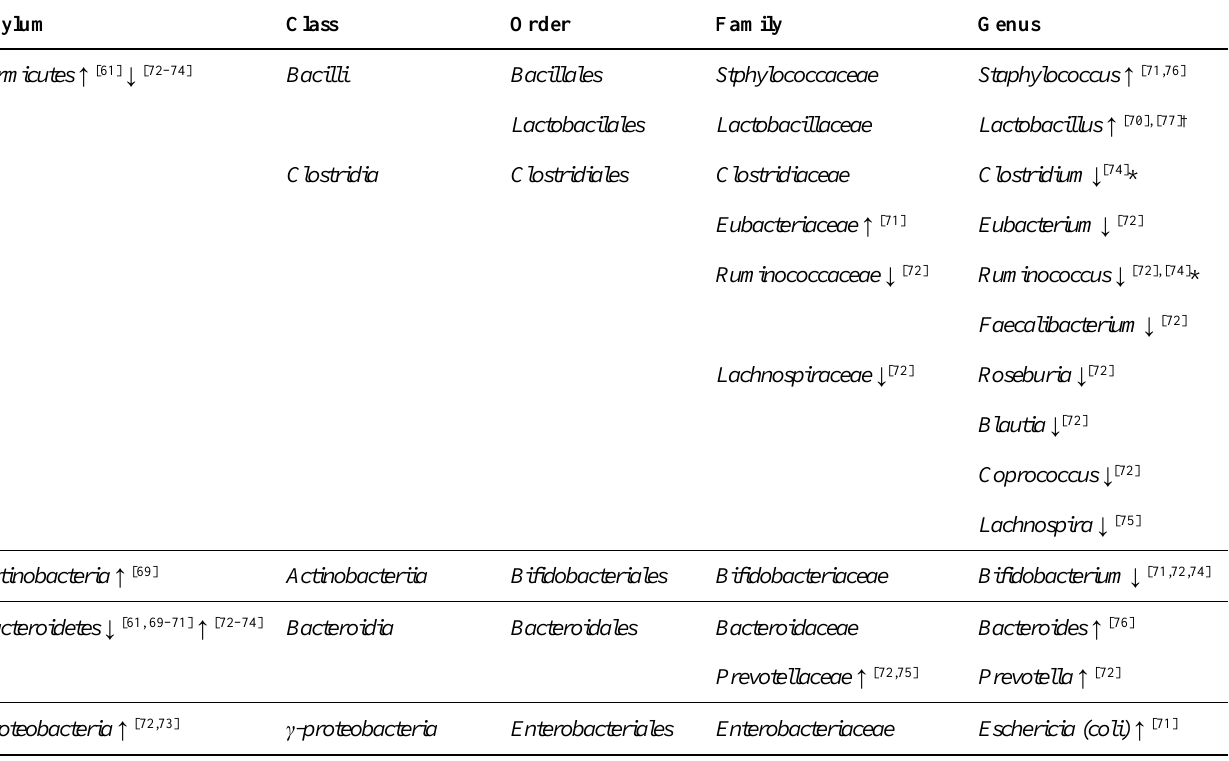
Table 2. Changes in intestinal microbiota associated with clinical studies on